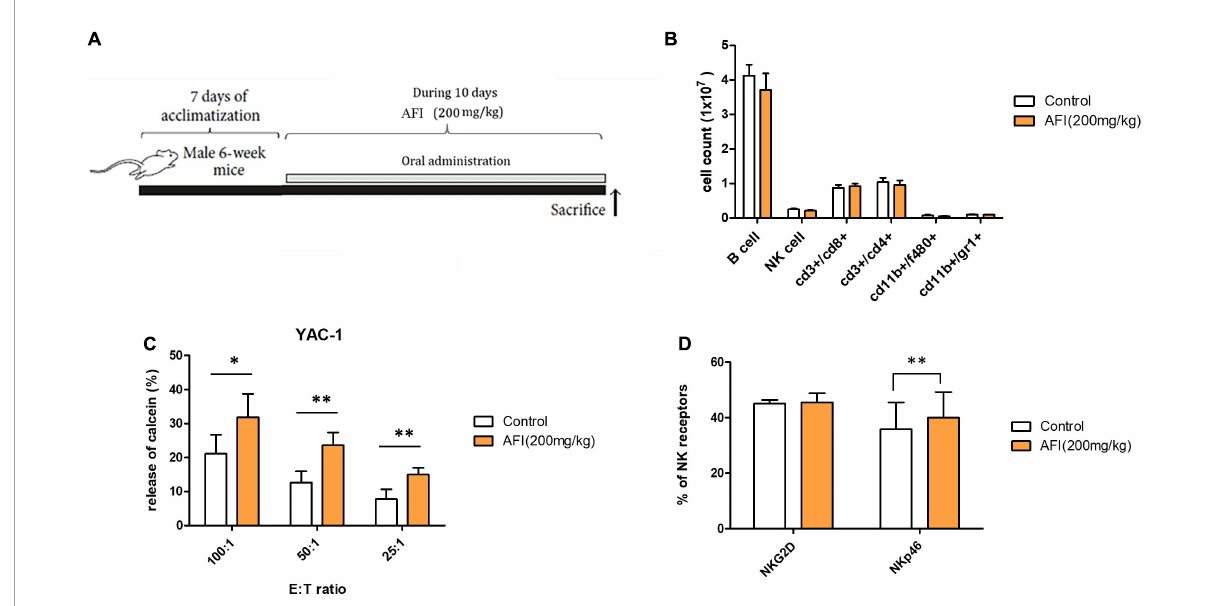
FIGURE5 Administration of Aurantii Fructus Immaturus (AFI) enhances the cytolytic activity of natural killer (NK) cells in vivo . (A) Overall scheme to investigate the NK activity-inducing effect of AFI orally administered to mice. (B) Immune cells were analyzed in the mouse spleen after the end of the AFI dosing period by flow cytometry. Three independent experiments were conducted, with five mice per group. (C) Splenocytes from each group were isolated, and NK cytotoxicity was measured against YAC-1 cells according to the indicated E:T ratio. (D) After the AFI administration period, only NK cells were gated from splenocytes, and the expression of NKG2D and NKp46 was measured through flow cytometry. Bars represent the mean ± SEM of three independent experiments ∗ p < 0.05 and ∗∗ p <